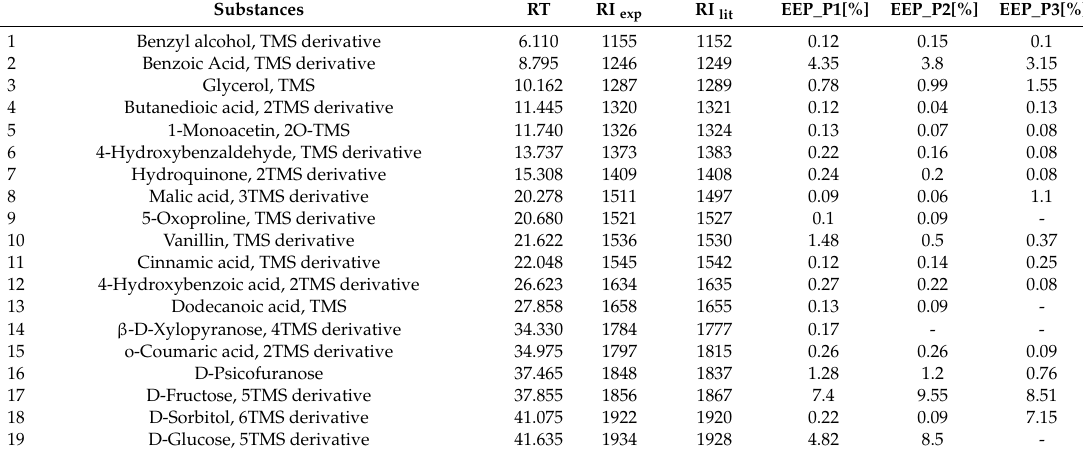
Table A1. GC-MS profile of ethanol extracts of propolis (EEP) from di ff erent regions of